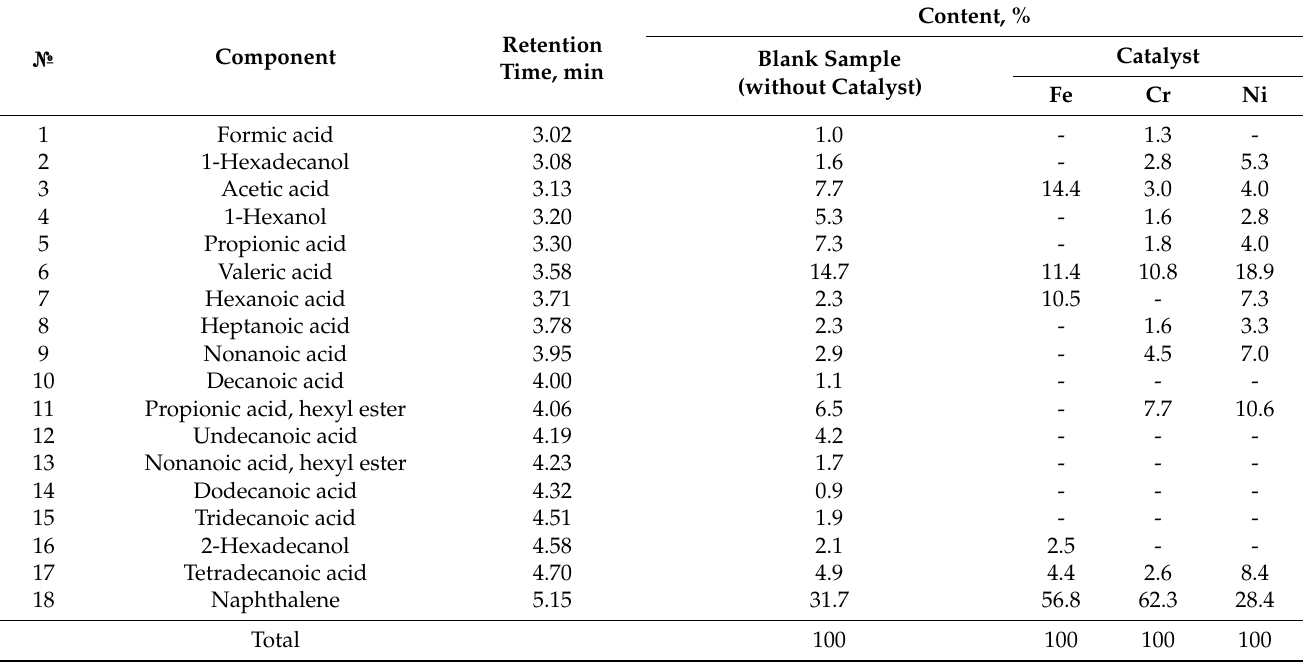
Table 2. The composition of liquid oxidation products in the presence and absence of catalysts for silica extracts (estimated from the GC-MS spectra provided in Figure